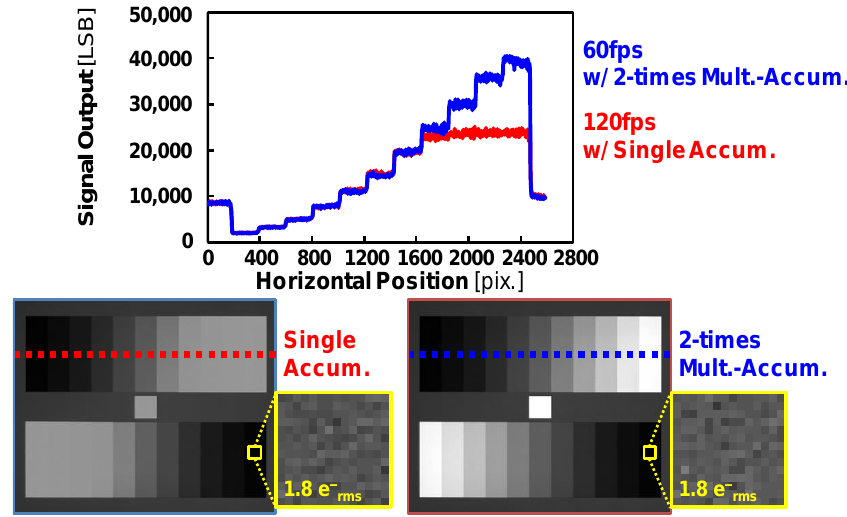
Figure 11. Measured output characteristics.